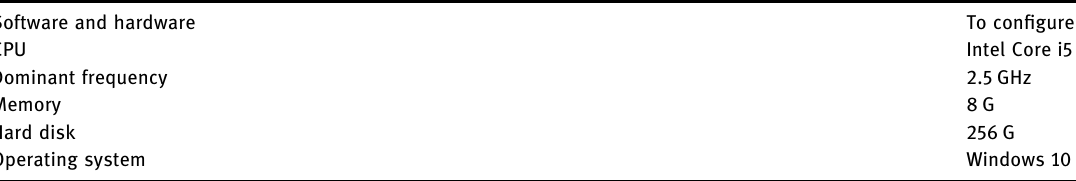
Table 3: Experimental con fi guration